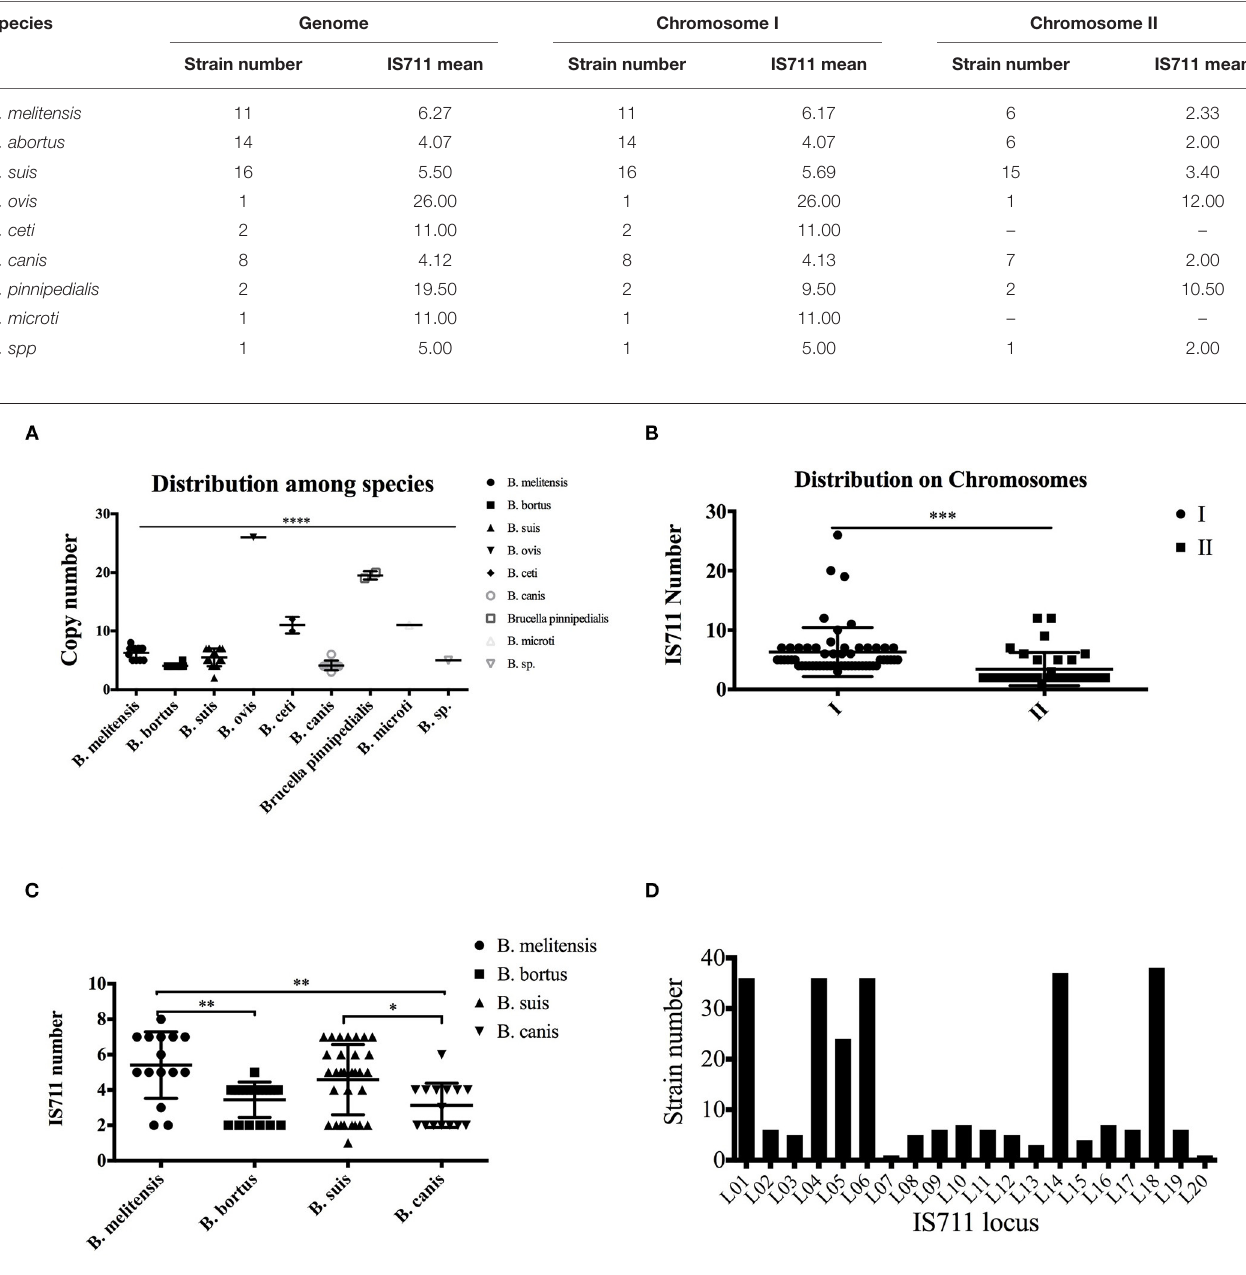
value of BMEI1001 (32.8). Interestingly, this is contrary to